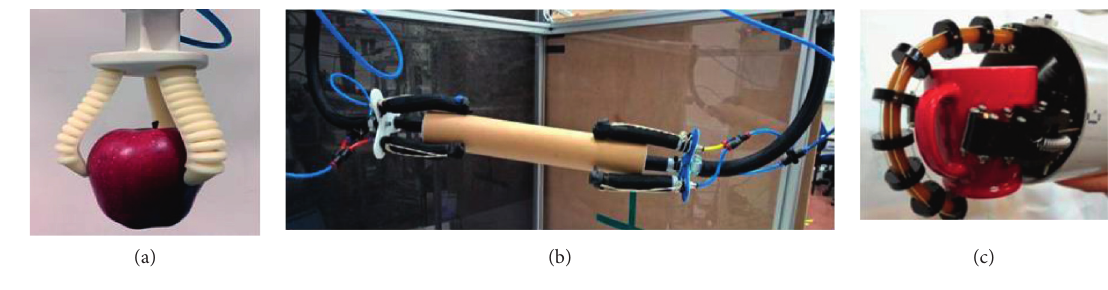
Figure 5: Continuum robots: human arm inspired [135, 151]. Table 3: Human hand-inspired continuum model